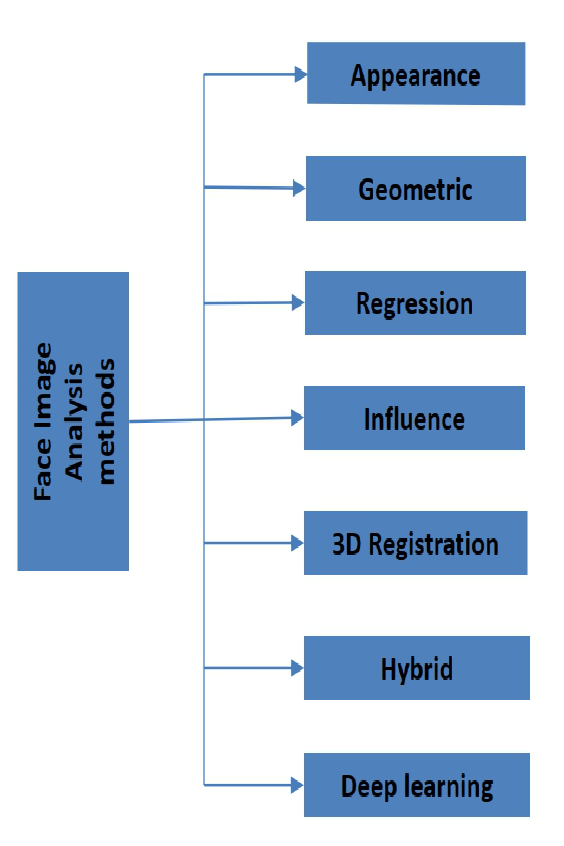
Figure 2. FIA methods and